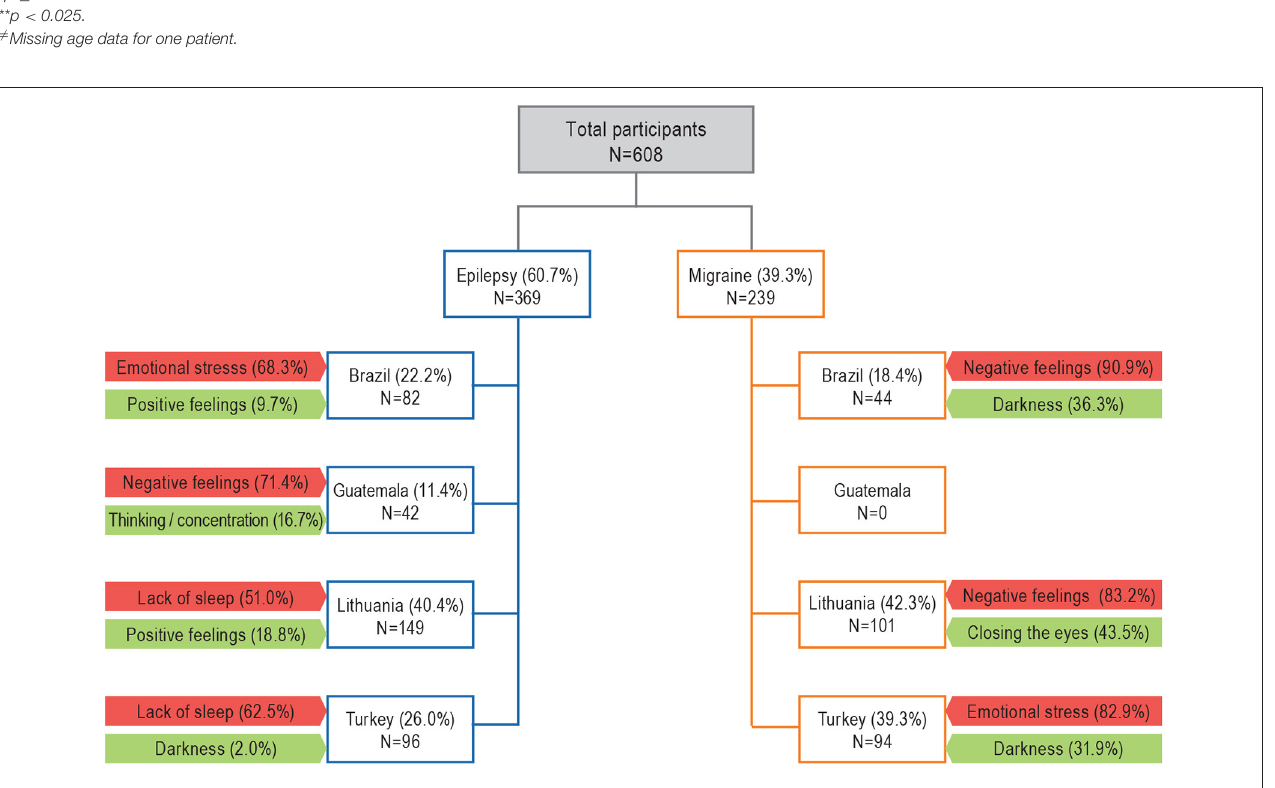
A comparison of the two groups here was made according to the median age of epilepsy patients. Statistical calculations were done among those who were exposed to modulatory factors. The bold and underlined ones are statistically significant rates according to adjusted residual ( ≥ 2) values, and Bonferroni-corrected p-values were calculated according to